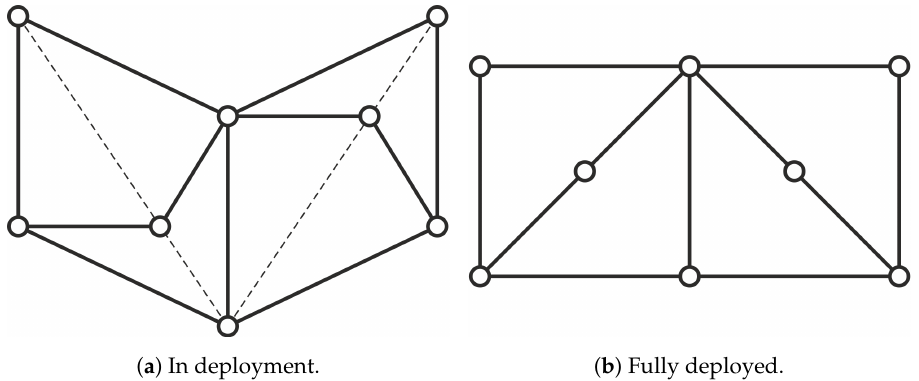
Figure 2. Deployment sequence of the proposed elementary